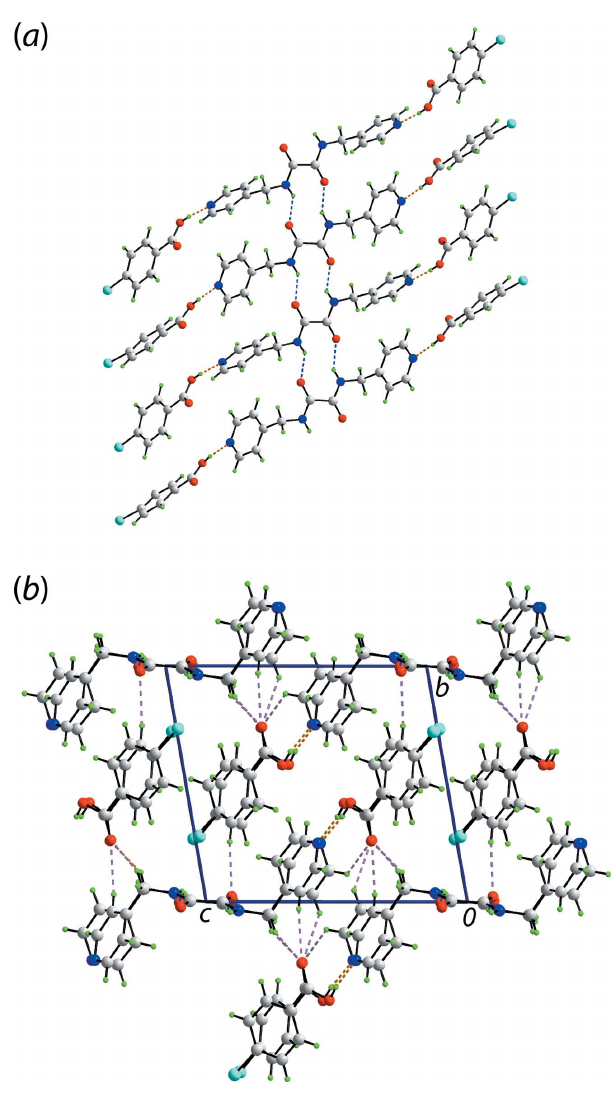
Figure 3 Molecular packing in the crystal of (I): ( a ) supramolecular tape comprising three-molecule aggregates, each sustained by carboxylic acid-O—H (cid:2)(cid:2)(cid:2) N(pyridyl) hydrogen bonding (orange dashed lines), linked by amide-N—H (cid:2)(cid:2)(cid:2) O(amide) (blue dashed lines) hydrogen bonding and ( b ) a view of the unit-cell contents down the a axis with C—H (cid:2)(cid:2)(cid:2) O interactions highlighted by pink dashed lines.